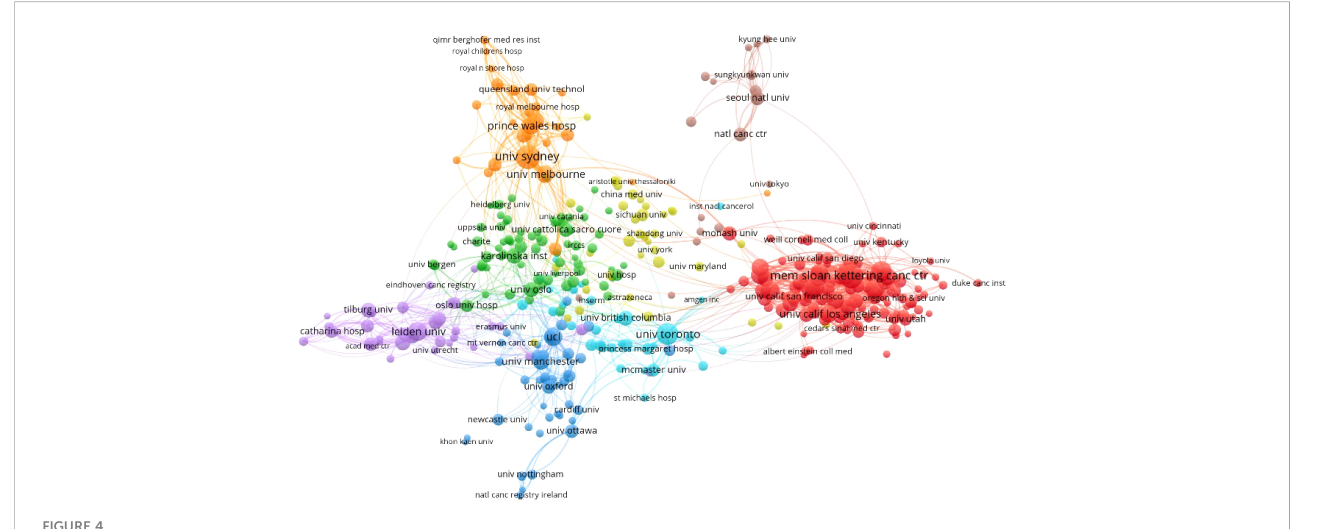
FIGURE 4 The co-authorship of the institution network.